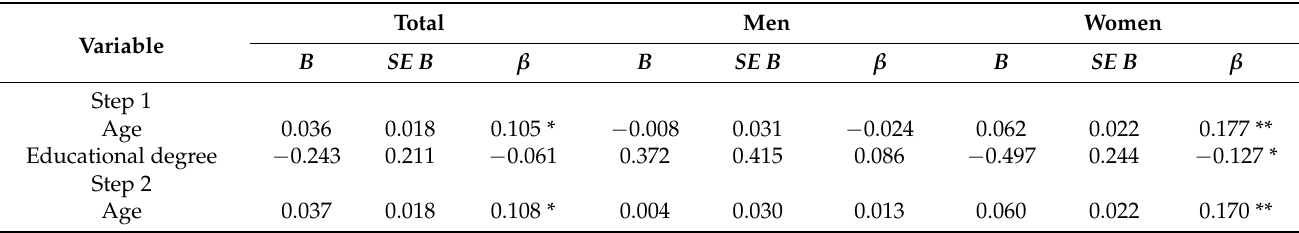
Table 5. Multiple regression of Dark Triad traits on emotional eating by